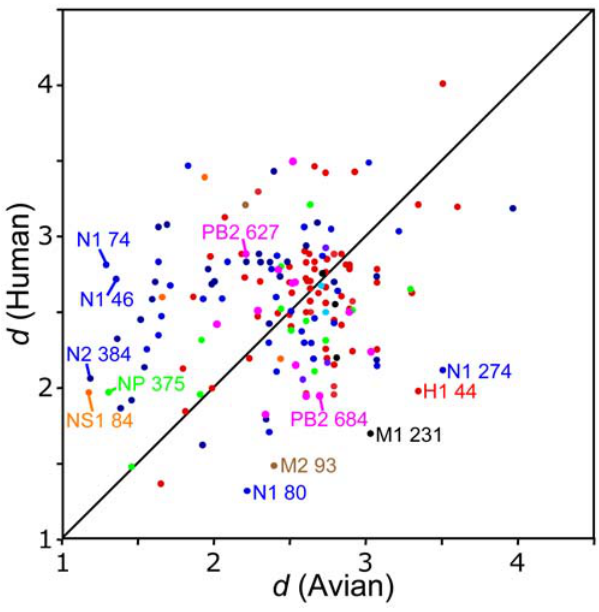
Figure 4. Selective constraint strengths for viral sites in Avian and Human influenza. Strength of selective constraints (measured as d , as described in Eqn. 5), for viral sites identified (FDR , 0.05) as under different selective constraints in avian and human hosts. Colour coding refers to specific gene: HA (red), NA (blue), M1 (black), M2 (brown), NP (green), NS1 (orange), PA (cyan), PB1 (purple), PB2 (magenta). Selective sites are labelled.